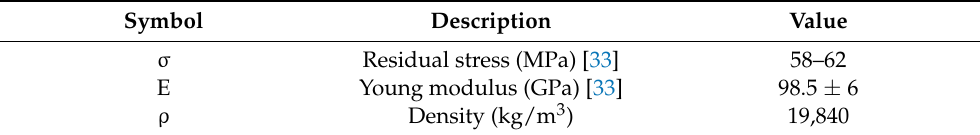
Table 2. Gold material properties Reproduced with permission from Ref. [24]. 2017, Springer